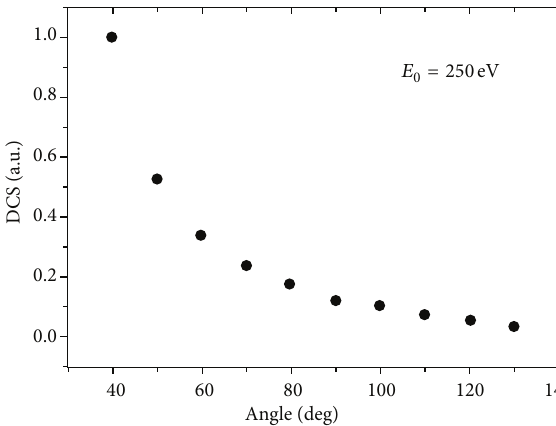
Figure 16: Elastic DCS at 250 eV electron impact energy for H 2 .